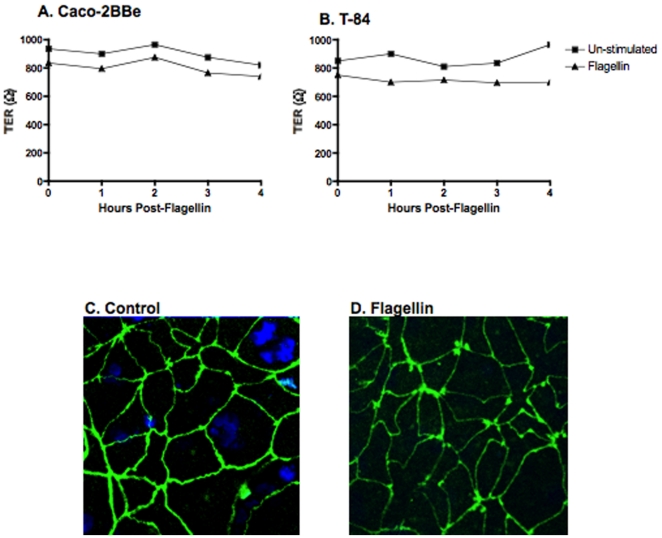
Flagellin does not interfere with intestinal barrier integrity.TER measurements were taken every hour for 4 h in the AP and BL chambers of polarized Caco-2BBe (A) and T-84 (B) cells exposed to flagellin that showed no significant change. C and D. Examination the tight junction protein, ZO-1 by confocal microscopy, in polarized Caco-2BBe cells. The appearance of the junctions stained with anti-ZO-1 antibody and appropriate secondary antibody (green) did not change following exposure of flagellin to the AP surface. Cell nuclei with stained with DAPI (blue). The confocal images shown are representative of 2 experiments.